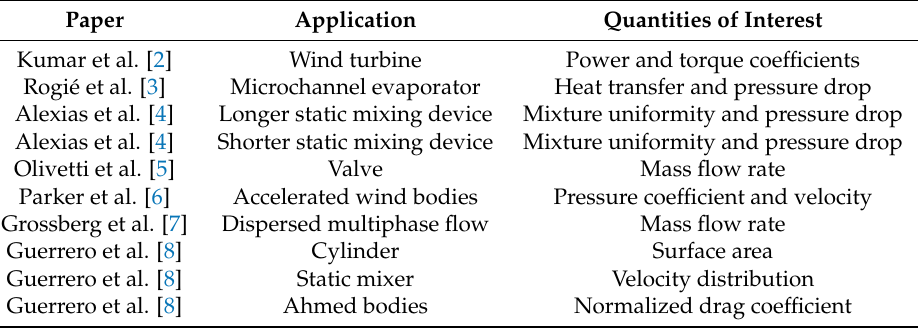
Table 1. Overview of Special Issue research contributions: Applications and Quantities of Interest.